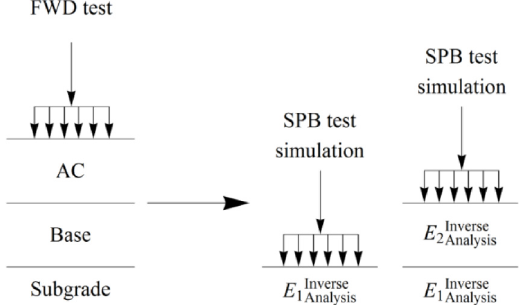
Table 2. Mean values of C and n coefficients identified for purposes of plate bearing test simulation on pavement